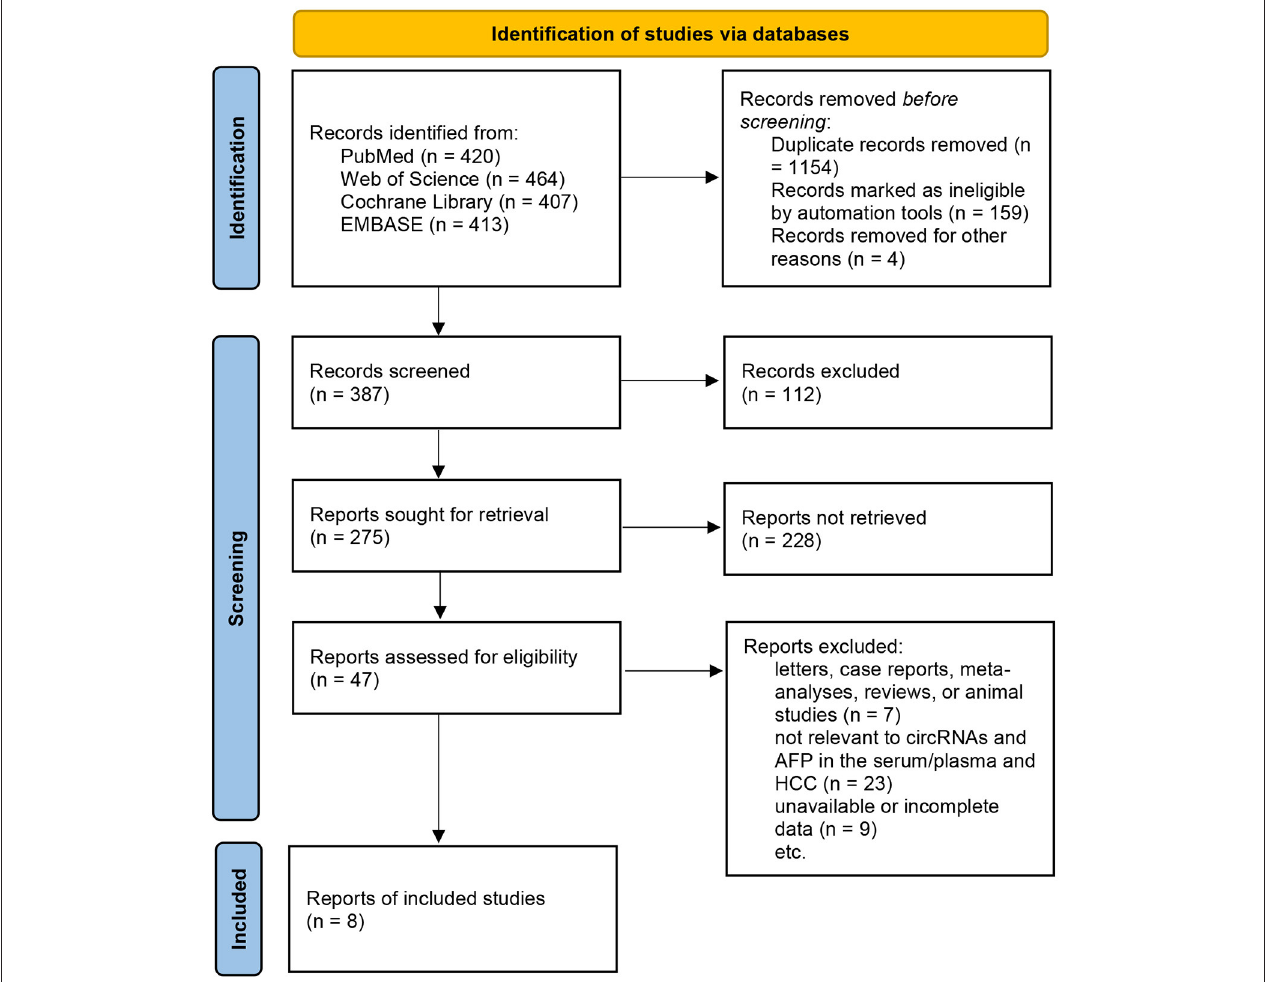
FIGURE 1 | Flow-process diagram of the study selection